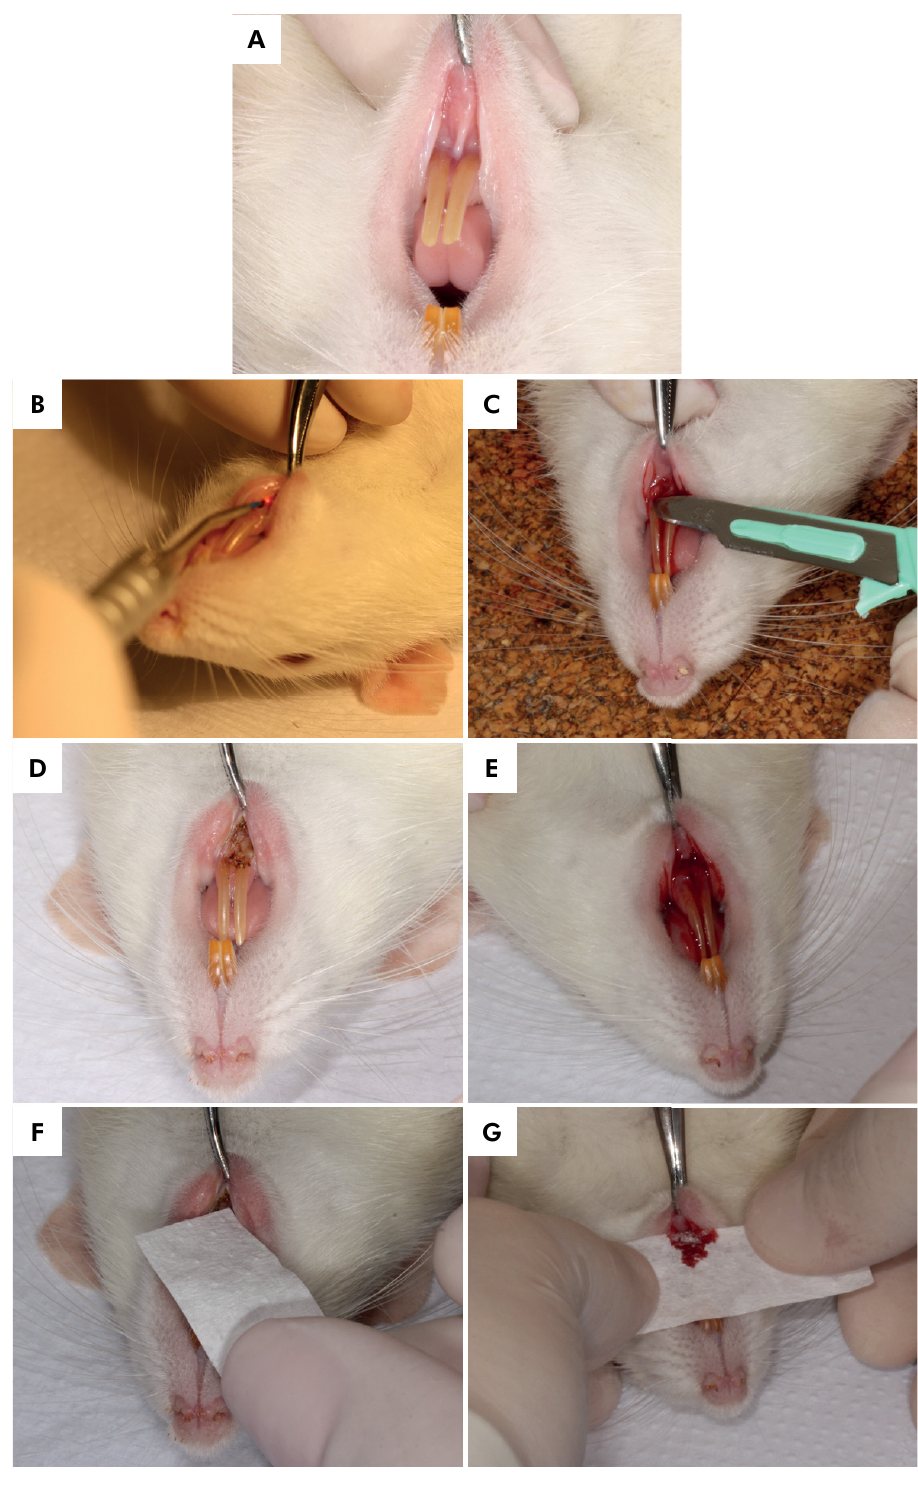
Figure 1. A – Rat labial frenum before surgery; B – Labial frenectomy being performed by high-power diode laser; C- Labial frenectomy being performed by scalpel; D – Rat labial frenum immediately after frenectomy performed by diode high-power laser; E – Rat labial frenum immediately after frenectomy performed by scalpel; F – Bleeding time evaluation with filter paper blotted every 30 seconds, above surgical site, in the high-power diode laser group; G - Bleeding time evaluation with filter paper blotted every 30 seconds, above surgical site, in the Scalpel